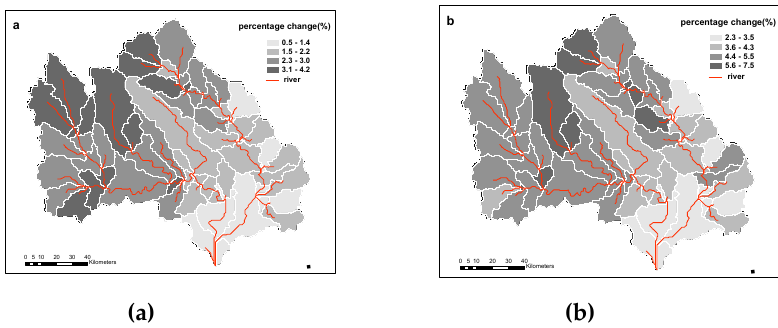
Figure 15. Spatial distribution of annual ET percentage changes under ( a ) 1.5 °C, ( b ) 2.0 °C global warming. Table 4. Correlation coefficient of percentage change in WBC and land use, soil